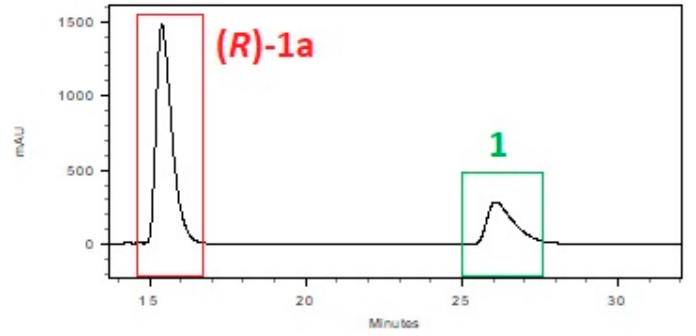
Figure 1. Reduction of 1 in phosphate buffer solution (pH = 7.0) with sucrose.